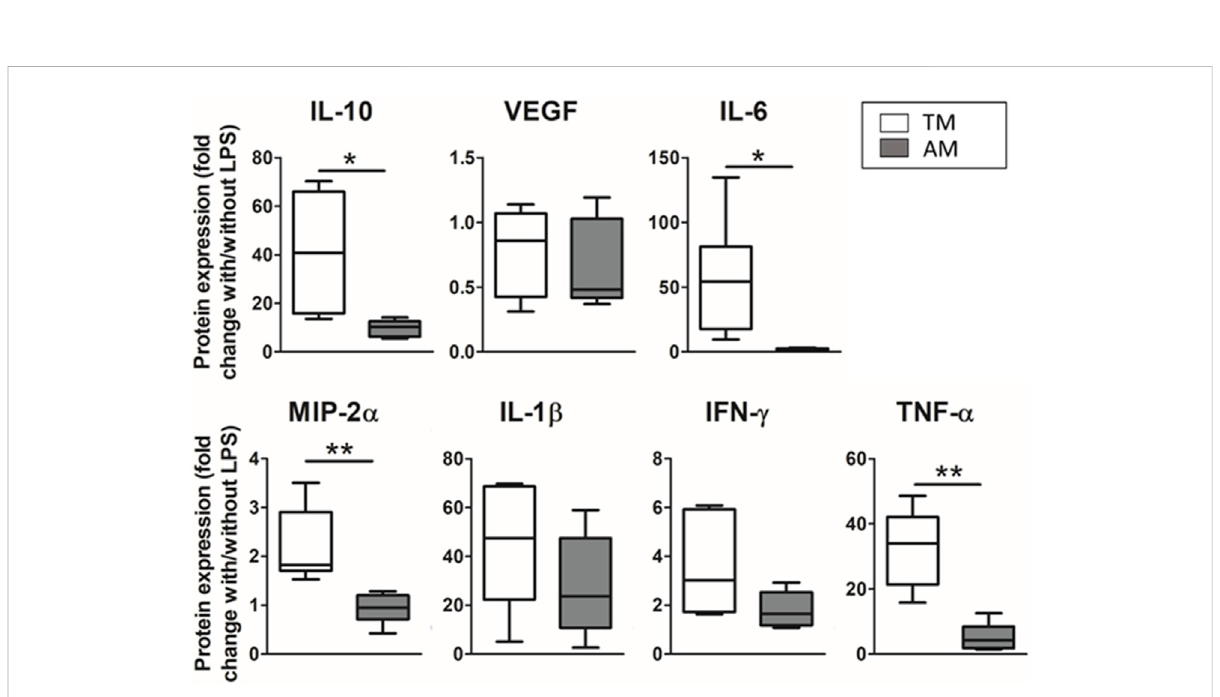
FIGURE 6 Different magnitude response of the advanced model (ATII cultured on hydrogels with 3D-cultured LMSC inside) compared to a traditional 2D culture model (ATII cell cultured on PDMS). Results were expressed as the ratio of cytokines expressed with/out the LPS hit, for either the traditional model or the advanced